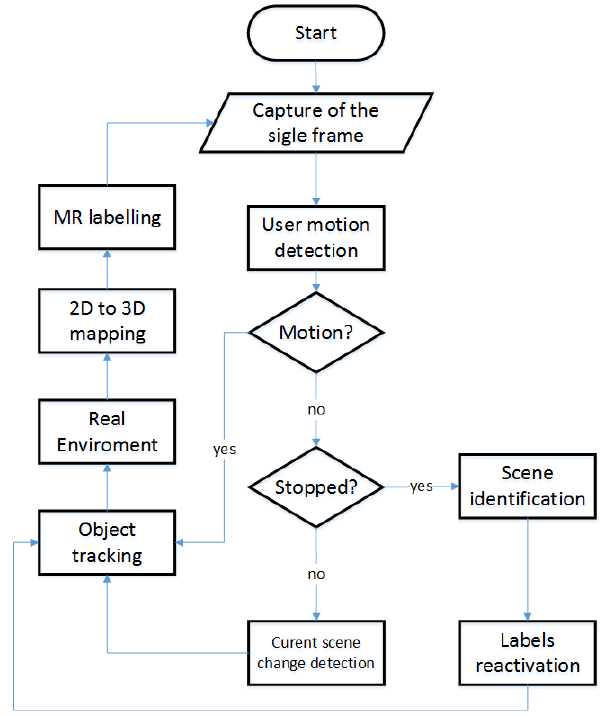
Figure 6. The 5MR system information flow diagram.